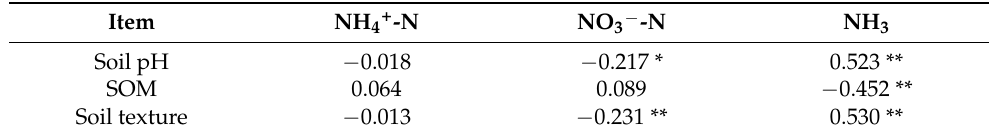
Table 4. Pearson correlation test between soil properties (pH, soil organic matter (SOM), and